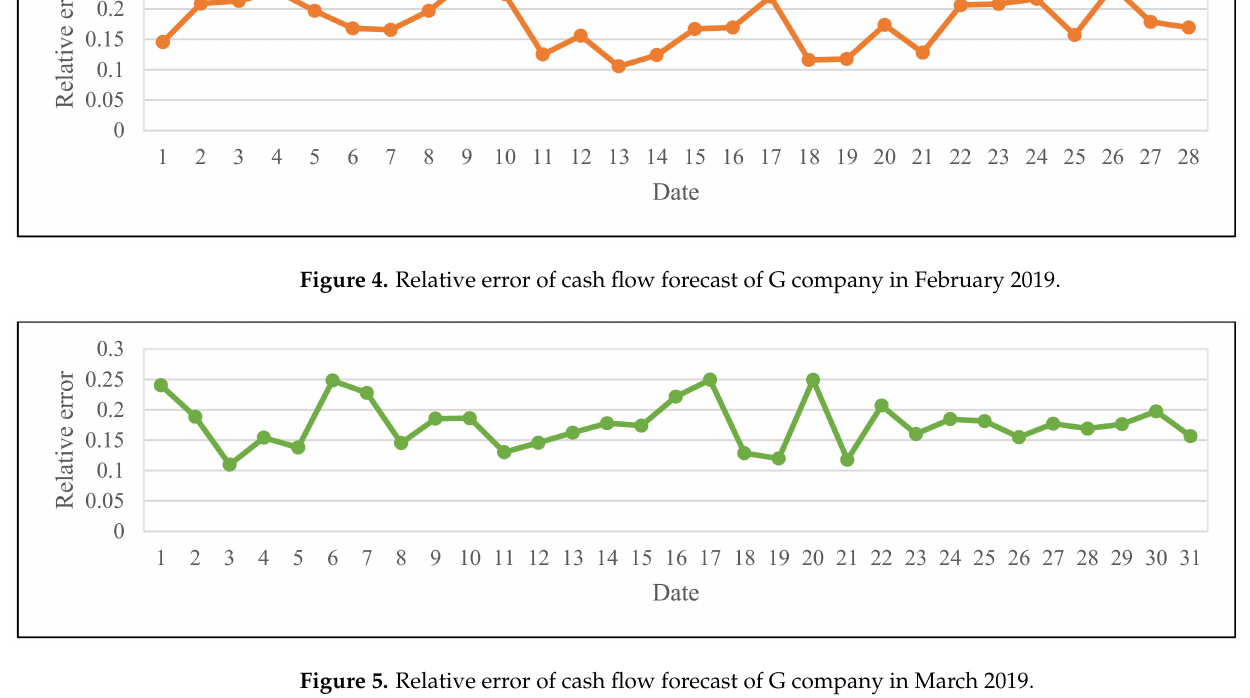
Figure 5. Relative error of cash flow forecast of G company in March 2019.